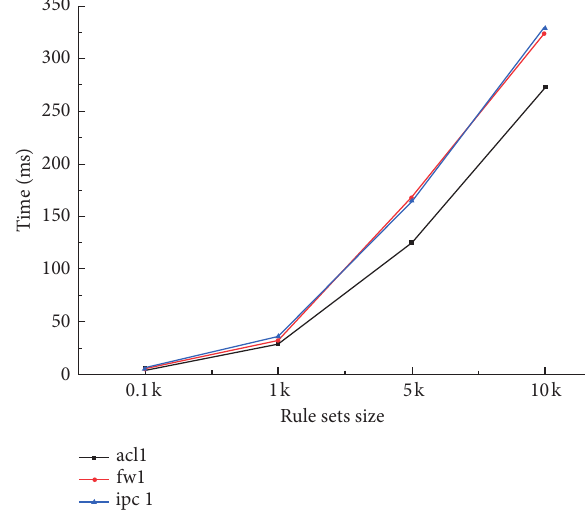
Figure 4: The preprocessing time for different rule sets with varying size for the PCIU algorithm.